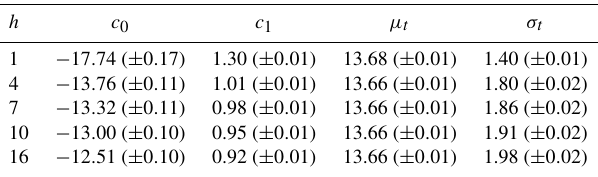
Table 2. Parameters of fitted logistic distributions as shown in Fig. 3 for various forecast lead times h , with coefficients of logistic regres- sions c 0 and c 1 and resulting means µ t and standard deviations σ t for threshold t = 13 . 9ms − 1 . Estimated uncertainties are given in